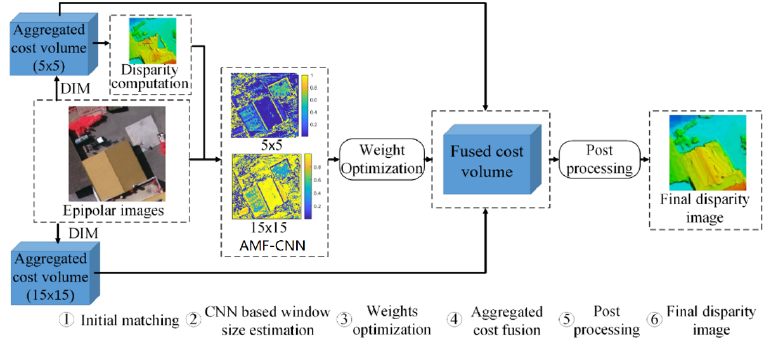
Figure 2. Overview of our work: 1 (cid:79) shows the input of our workflow; the aggregated matching cost volumes are computed from Semi-Global Matching (SGM), and then an initial disparity image is derived from the aggregated matching cost volumes of small matching windows. 2 (cid:79) shows the estimated weight maps of small windows and large windows. 3 (cid:79) is a process to refine weight maps. 4 (cid:79) shows the fused matching cost volume by weighted averaging the aggregated cost volumes of small and large windows. 5 (cid:79) is post-processing that includes Winner-Takes-All (WTA), Left-Right Consistency (LRC), and disparity interpolation. 6 (cid:79) shows the final disparity image using the proposed